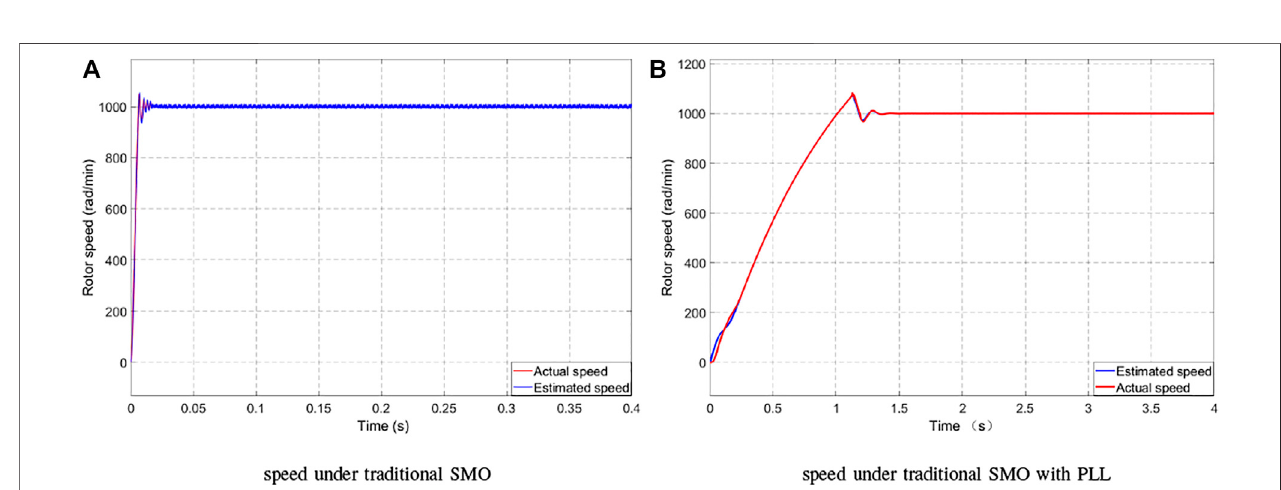
FIGURE 7 | Curve between the estimated and actual speeds. (A) Speed under traditional SMO. (B) Speed under traditional SMO with